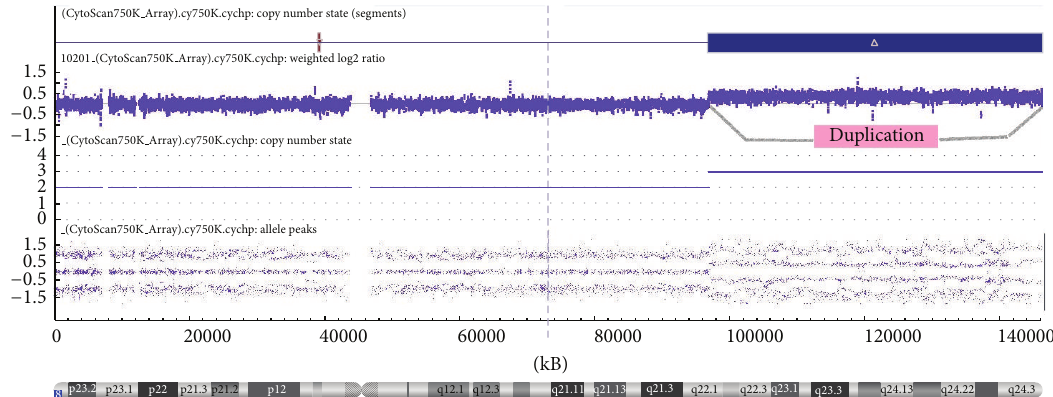
Figure 3: Ideogram showing duplication of 8q22.1–q24.3 detected by comparative genomic hybridization (CGH). Probe is ordered on the 𝑥 -axis according to physical mapping positions, with the p-arm probes to the left and q-arm probes to the right. Highlighted region